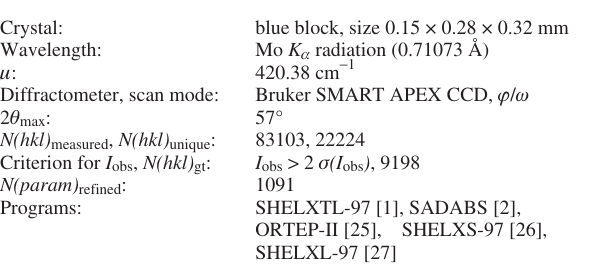
Table 1. Data collection and